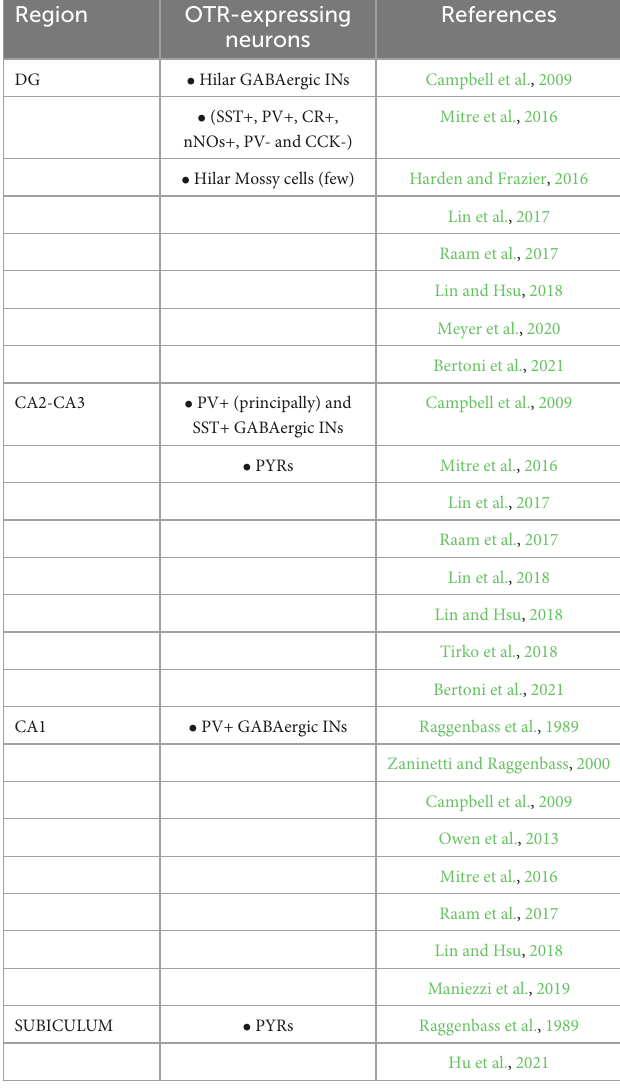
TABLE 1 Oxytocin receptor expression in hippocampal areas and neuronal phenotypes. Region OTR-expressing